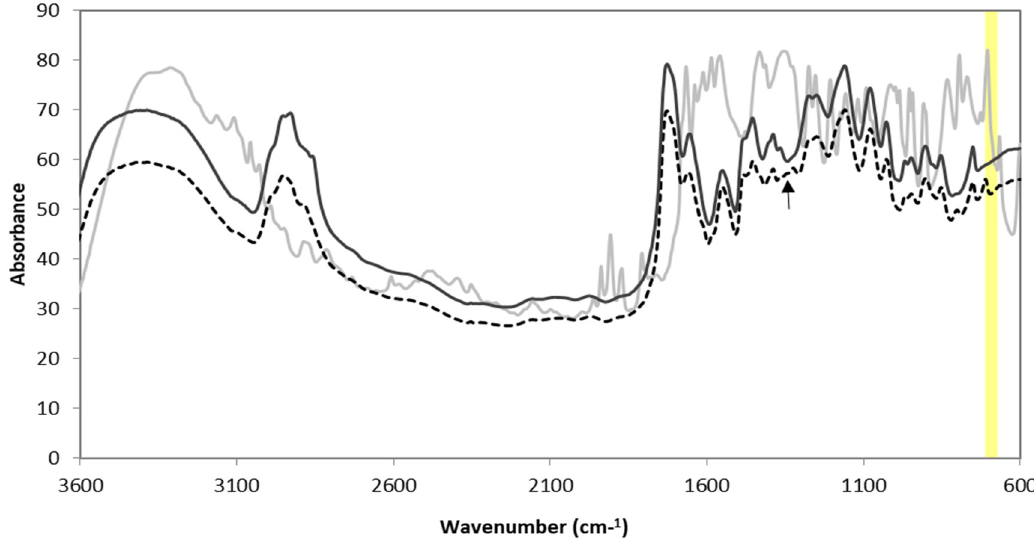
Figure 3. FTIR spectrum of 3AAPBA ( — ), poly(HEMA, BAC) nanoparticles ( — ), and poly(HEMA, BAC, 3AAPBA) nanoparticles (150) ( - - - ) (C6 fr—om Table